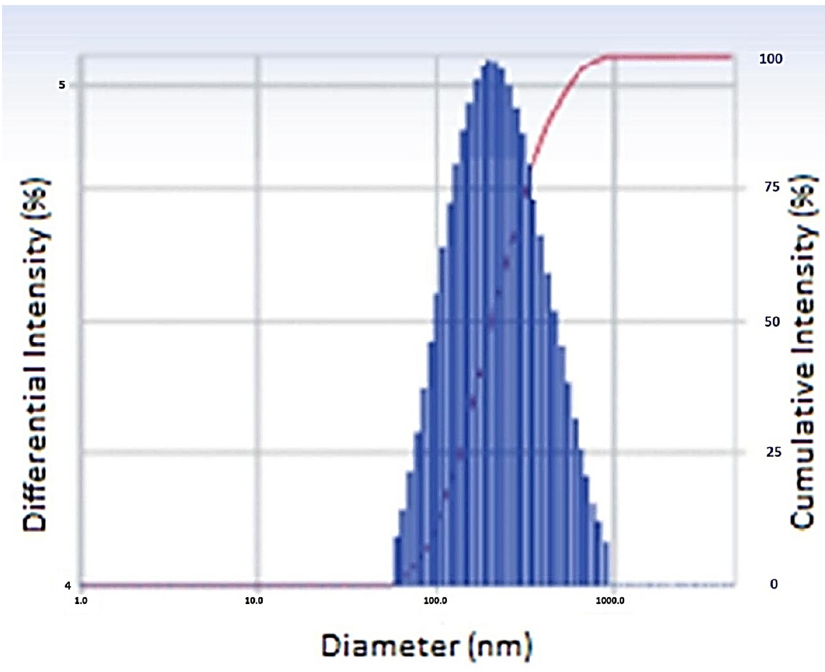
Figure 2. Particle size of optimized nanoparticles. Figure 2